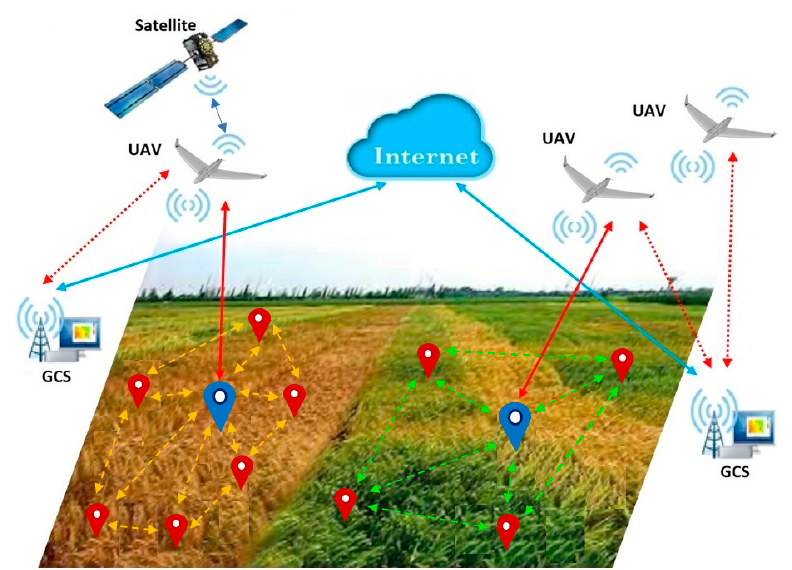
Figure 1. The concept of an integrated unmanned aerial vehicle-wireless sensor network (UAV–WSN) system.